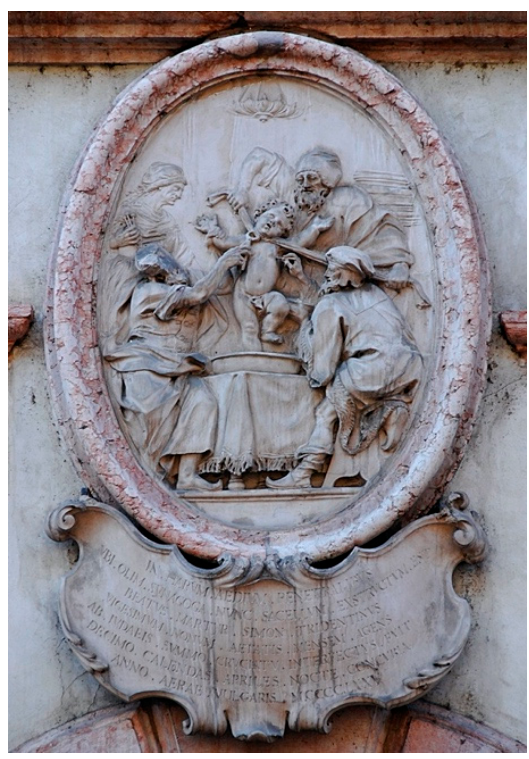
Figure 8. Francesco Oradini, medallion depicting the imagined martyrdom of Simon of Trent, marble, mid-eighteenth century, Palazzo Salvadori, Trento, Italy (Created by Andreas Caranti, CC BY-SA 2.0)